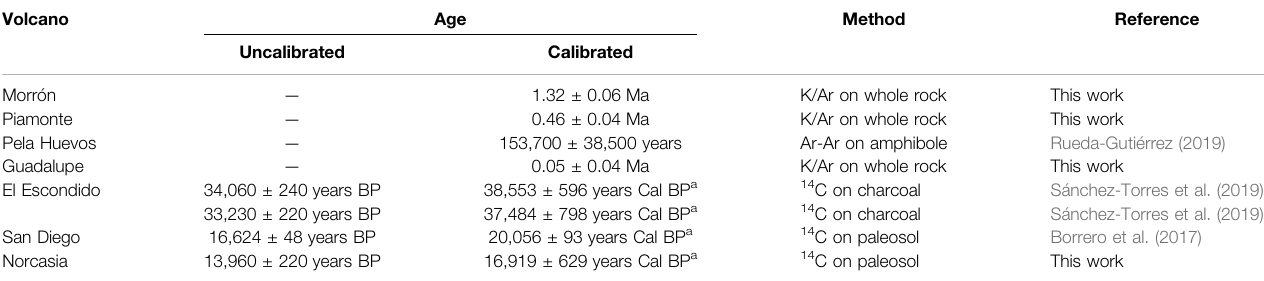
TABLE 4 | Ages of volcanic products in the Samaná monogenetic volcanic fi eld. Volcano